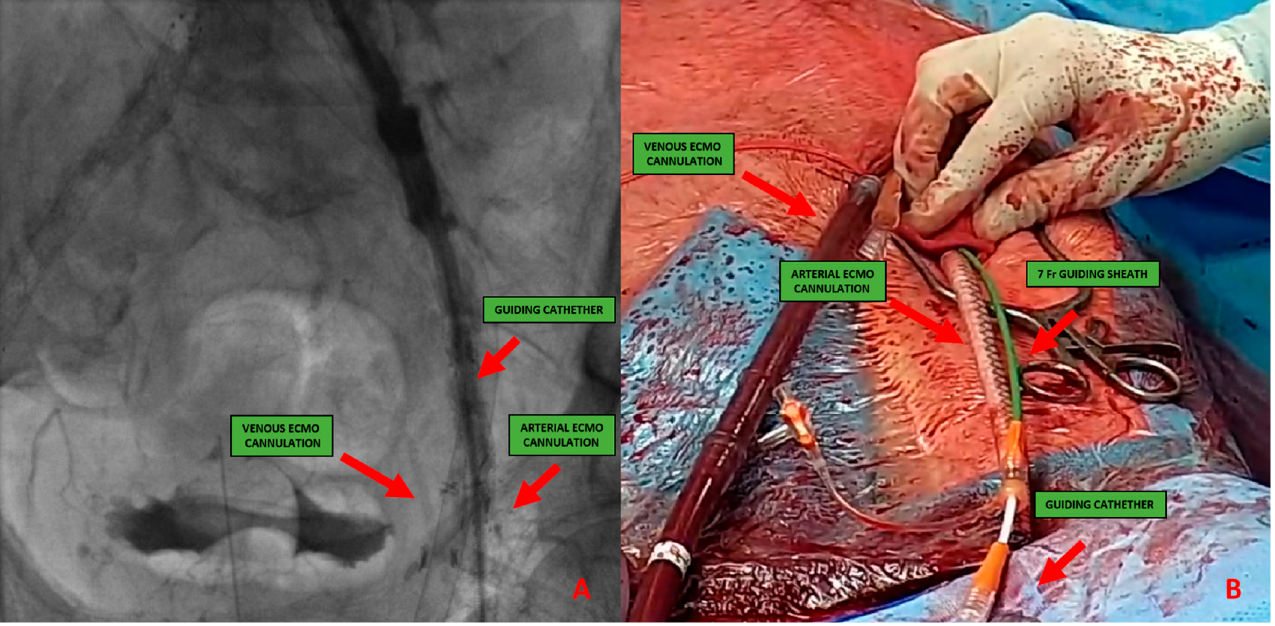
Figure 4. ( A ) 51-year-old man with history of: diabetes, chronic obstructive pulmonary desease (COPD), mild chronic kidney disease (GFR 56 ml/min) and peripheral artery disease (PAD) with previous percutaneous transluminal angioplasty (PTA) with stent implantation in the right external iliac artery, left iliac artery, left common femoral artery and subsequently aorto-bifemoral bypass surgery, referred to our center for HR-PCI A. Angiography evaluation after sheaths insertion. ( B ) Surgical cutdown with VA-ECMO cannulation and subsequently insertion of 7 Fr guiding sheats.